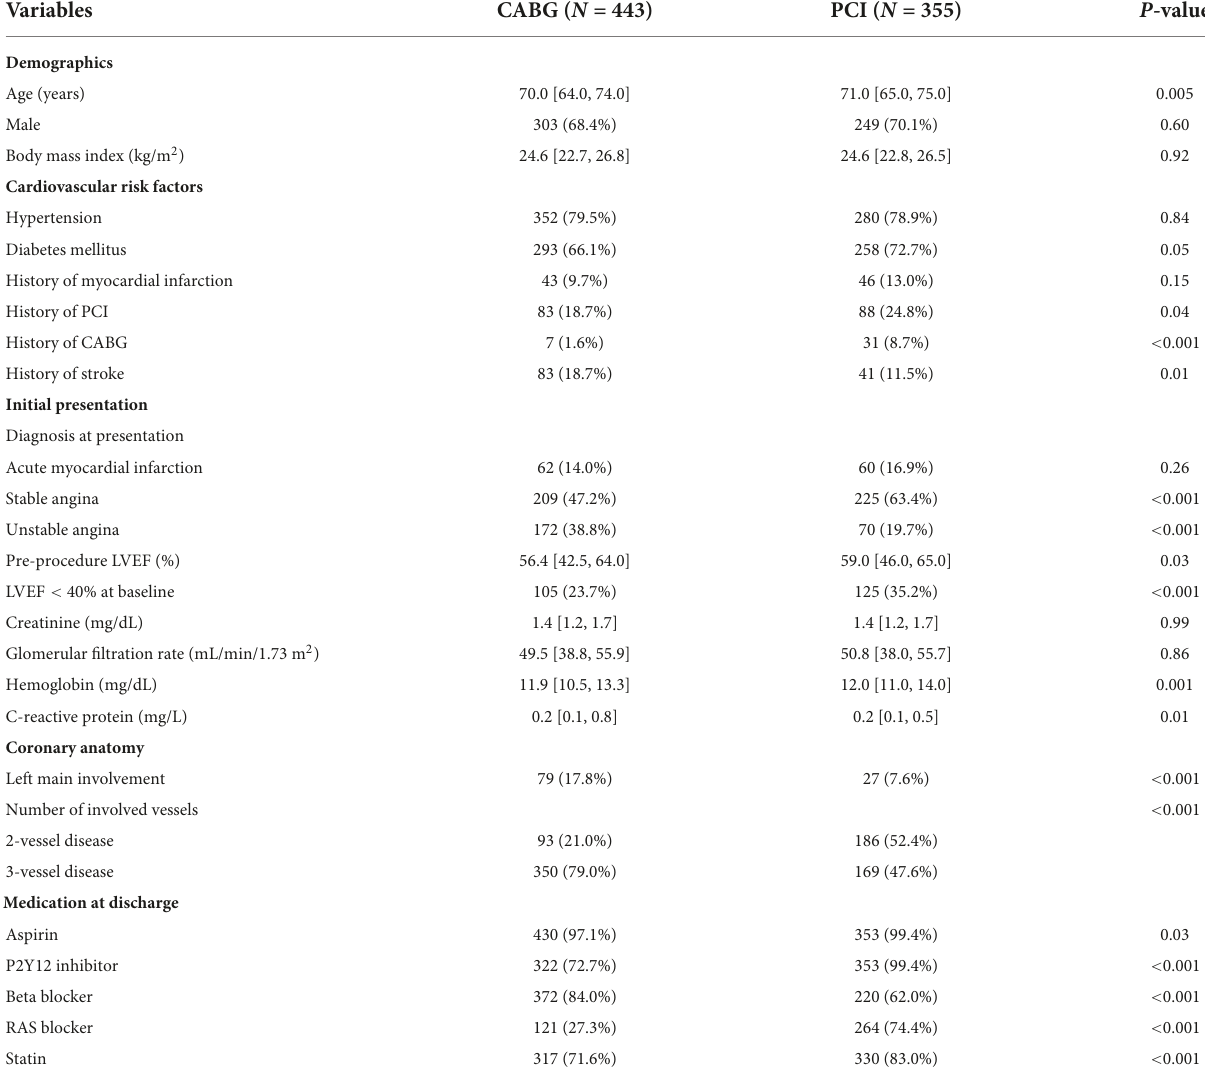
TABLE 1 Comparison of baseline characteristics according to the revascularization